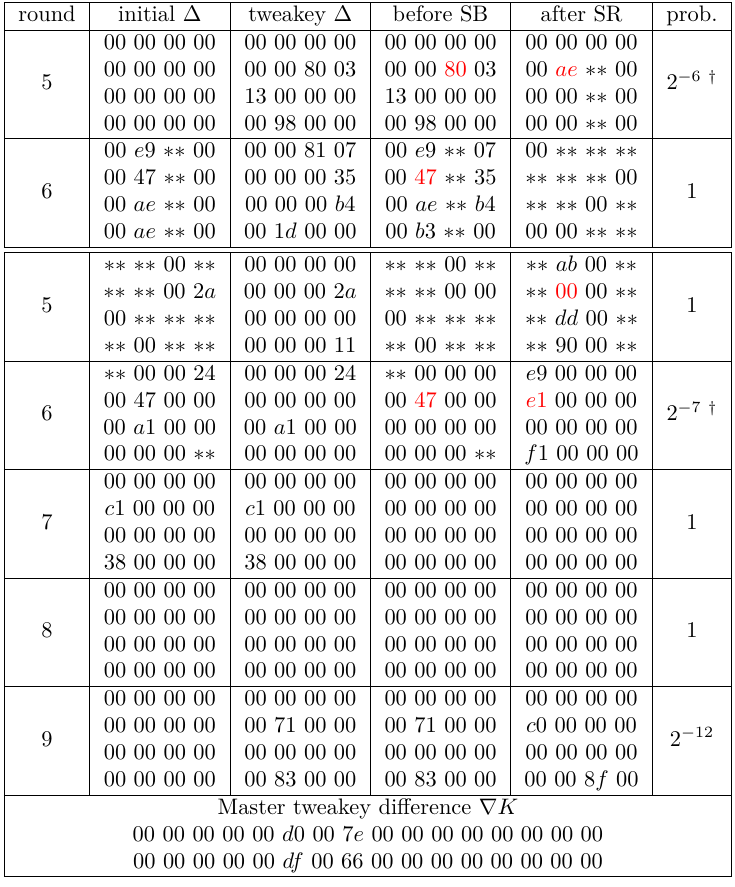
Table 7: Improved 9-round distinguisher for Deoxys -BC-256. The probabilities marked with † are only counted once due to the 2-round boomerang switch.